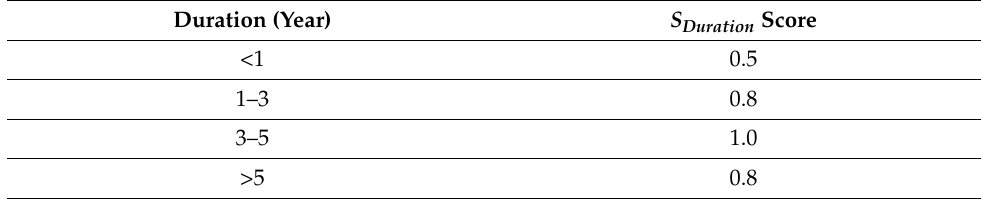
Table 8. The assessment rules of the monitoring